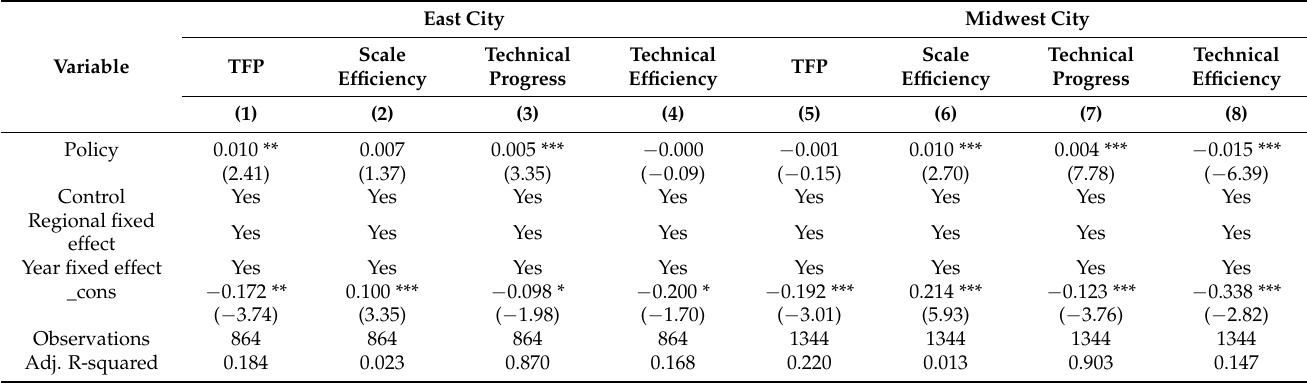
Table 8. Regional heterogeneity